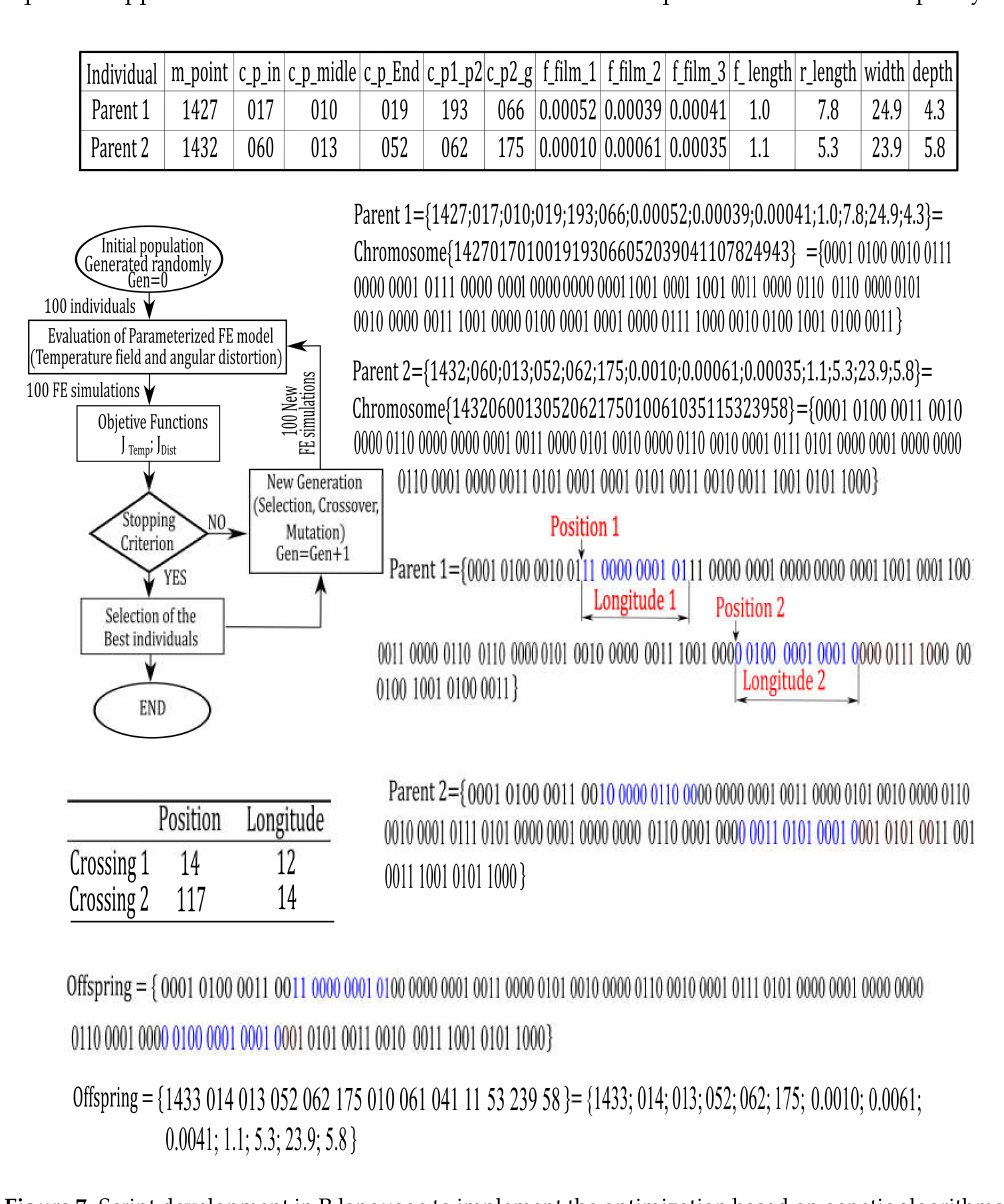
Figure 7. Script development in R language to implement the optimization based on genetic algorithms (GA) and details of the crossovers and mutations of the